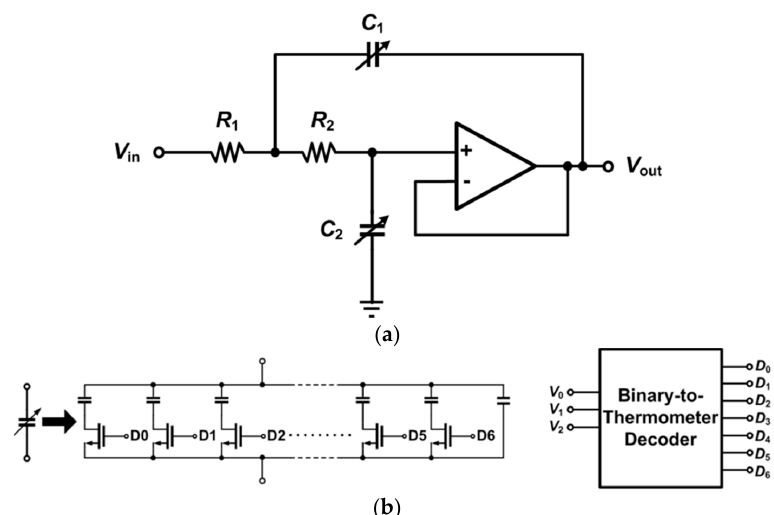
Figure 8. ( a ) Sallen-Key low-pass filter; ( b ) Cap-array schematic.